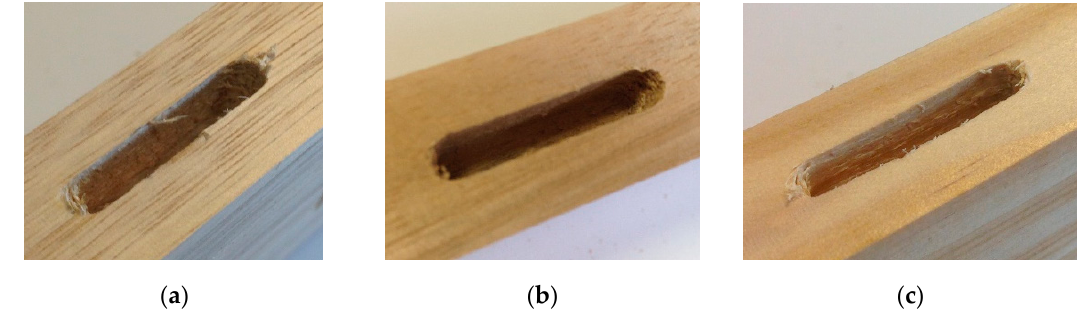
Figure 11. Examples of E. nitens ( a ) with a grade of G3 (fair) for fuzzy biscuit-bore grain and E. globulus ( b ) and P. radiata ( c ) with a grade of G2 (good). Table 7. Grading results according to biscuit boring.